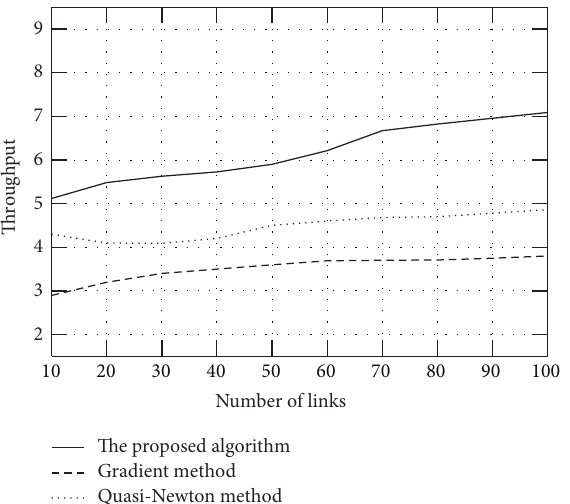
Figure 4: Throughput comparison with different